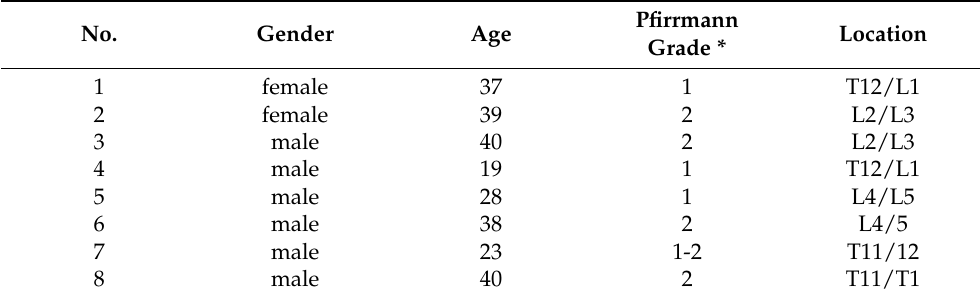
Table 1. Donor list with gender, age, Pfirrmann grade, tissue weight, and the number of isolated cells.